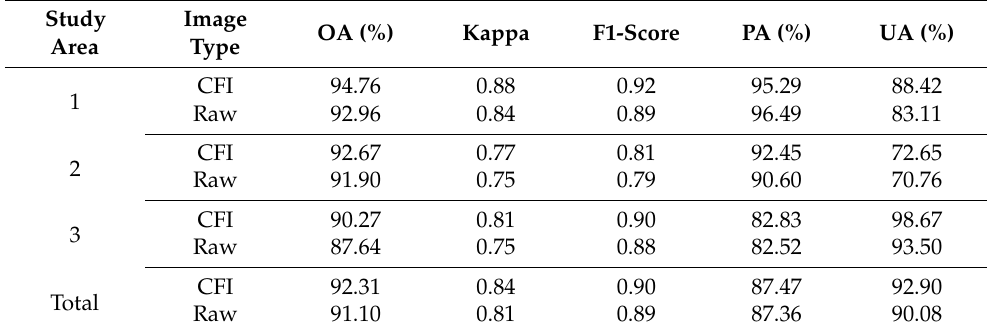
Table 3. Classification accuracy based on CFI images and Sentinel-2 raw images by using IsoData.